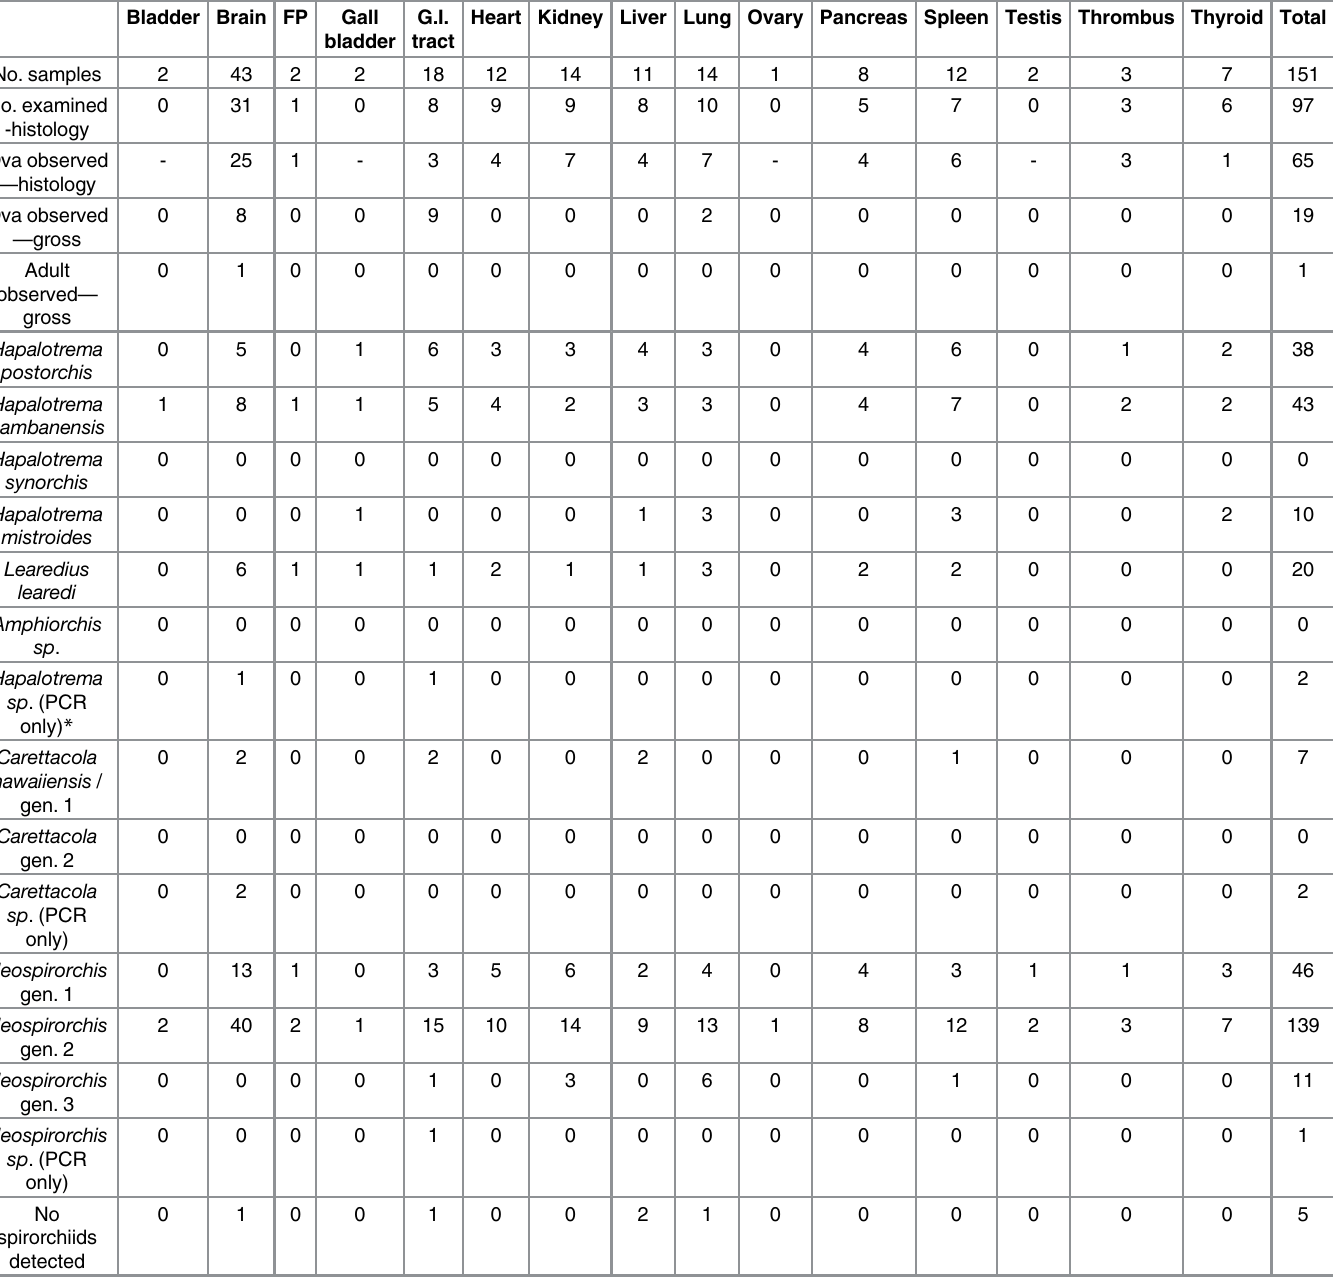
Table 3. Tissue samples tested by T-RFLP. Summaries of initial visual examination are given for each organ, including gross necropsy and histology find- ings. Columns headed with spirorchiid species/genotype names summarise T-RFLP results for each organ. Columns labelled ‘ PCR only ’ refer to positive PCR results where no subsequent T-RFLP result could be